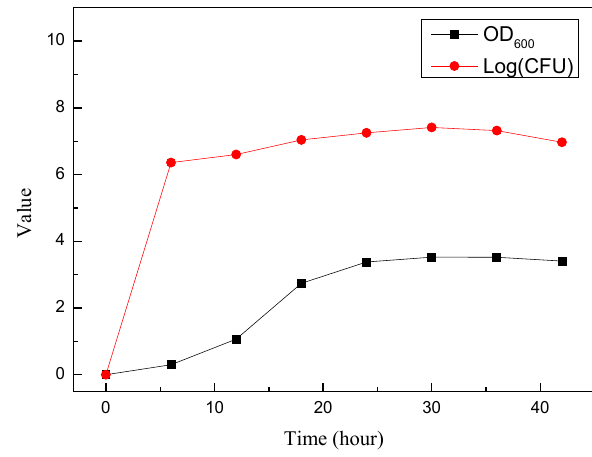
Figure 3: Growth curves of strain